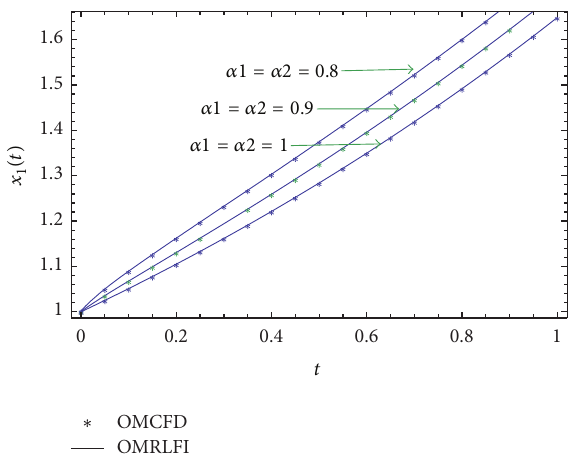
Figure 5: Approximate solutions of 𝑥 1 (𝑡) for 𝑚 = 10 and different values of 𝛼 1 , 𝛼 2 by OMCFD and OMRLFI in Example 13.